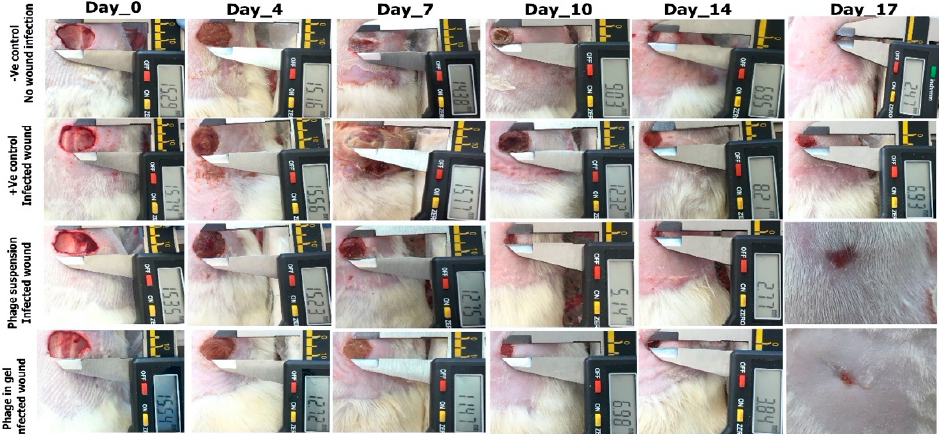
Figure 6. Morphometric examination of full-thickness excision wounds in rats at a fixed focal distance by Millimetre (mm) using digital photographs.